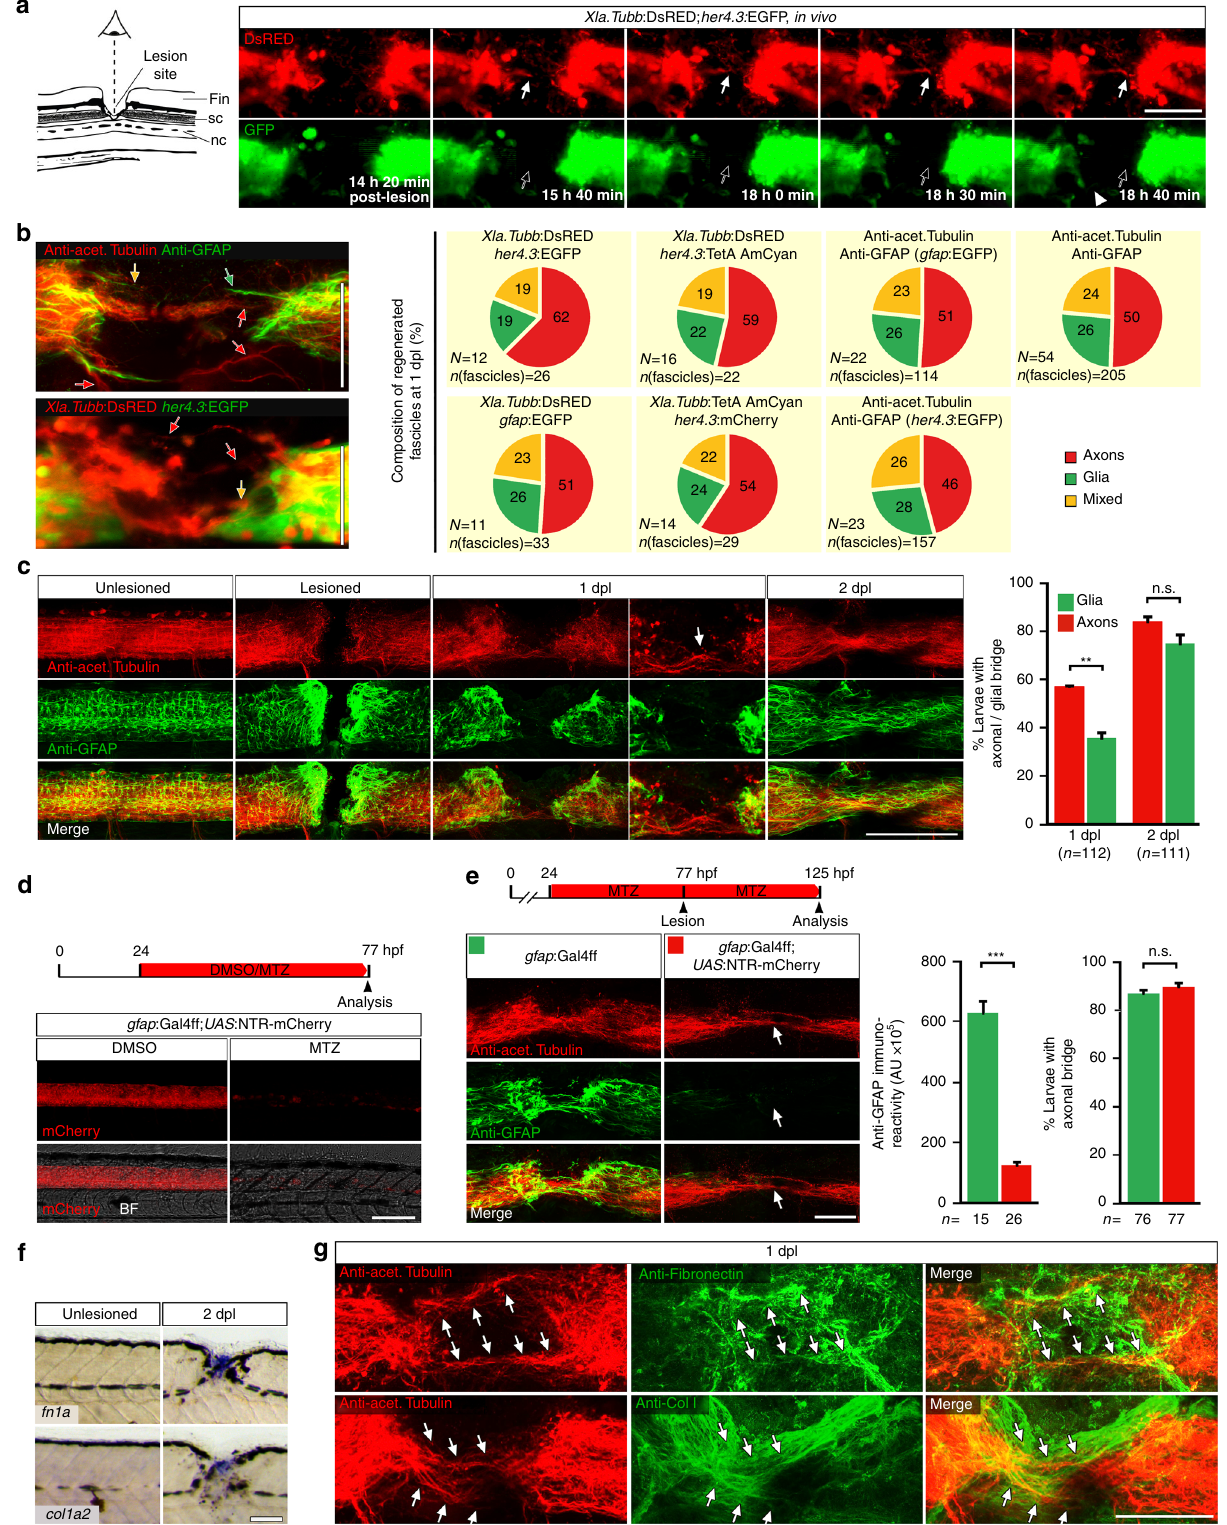
NATURE COMMUNICATIONS | 8: